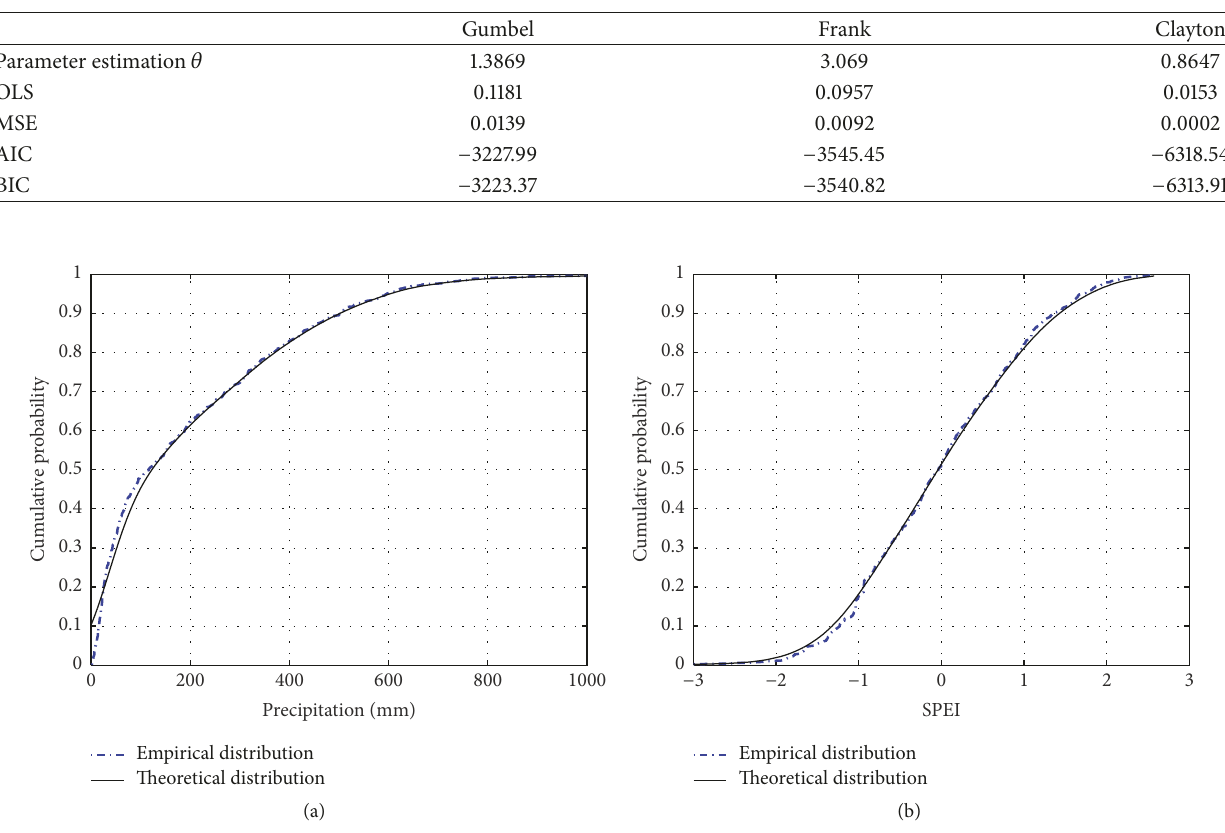
Table 3: Parameter estimation and criteria results of copula fitting.